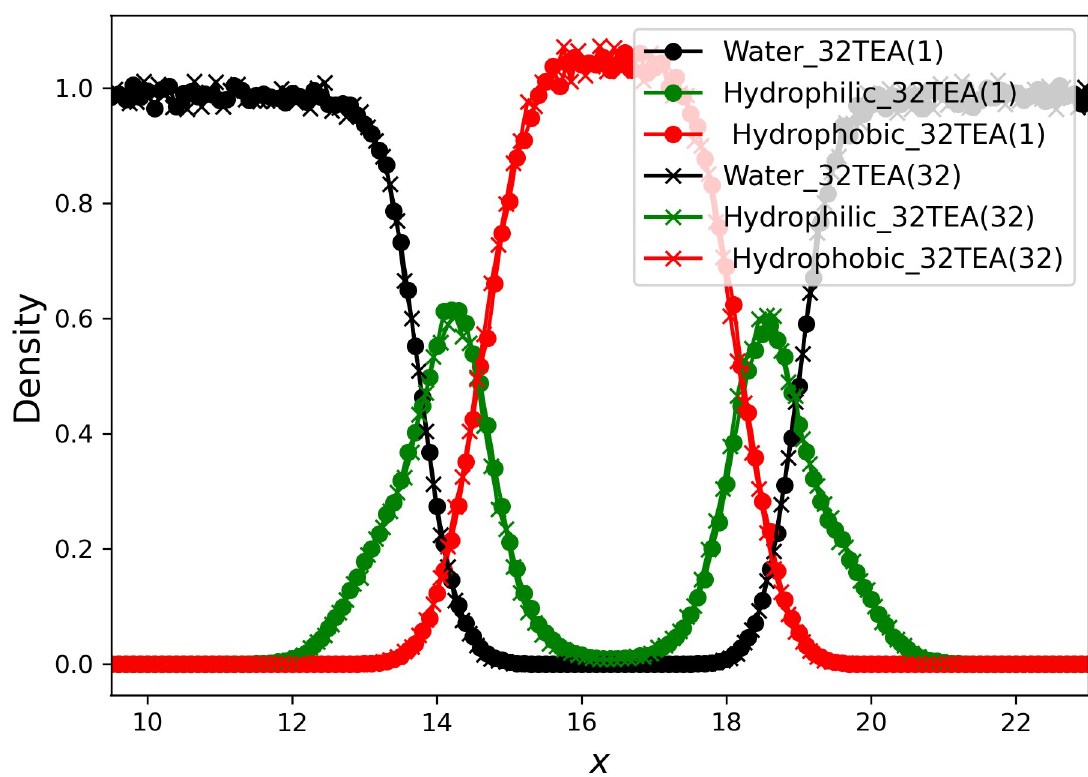
Fig 9. Density plot of each particle in the x